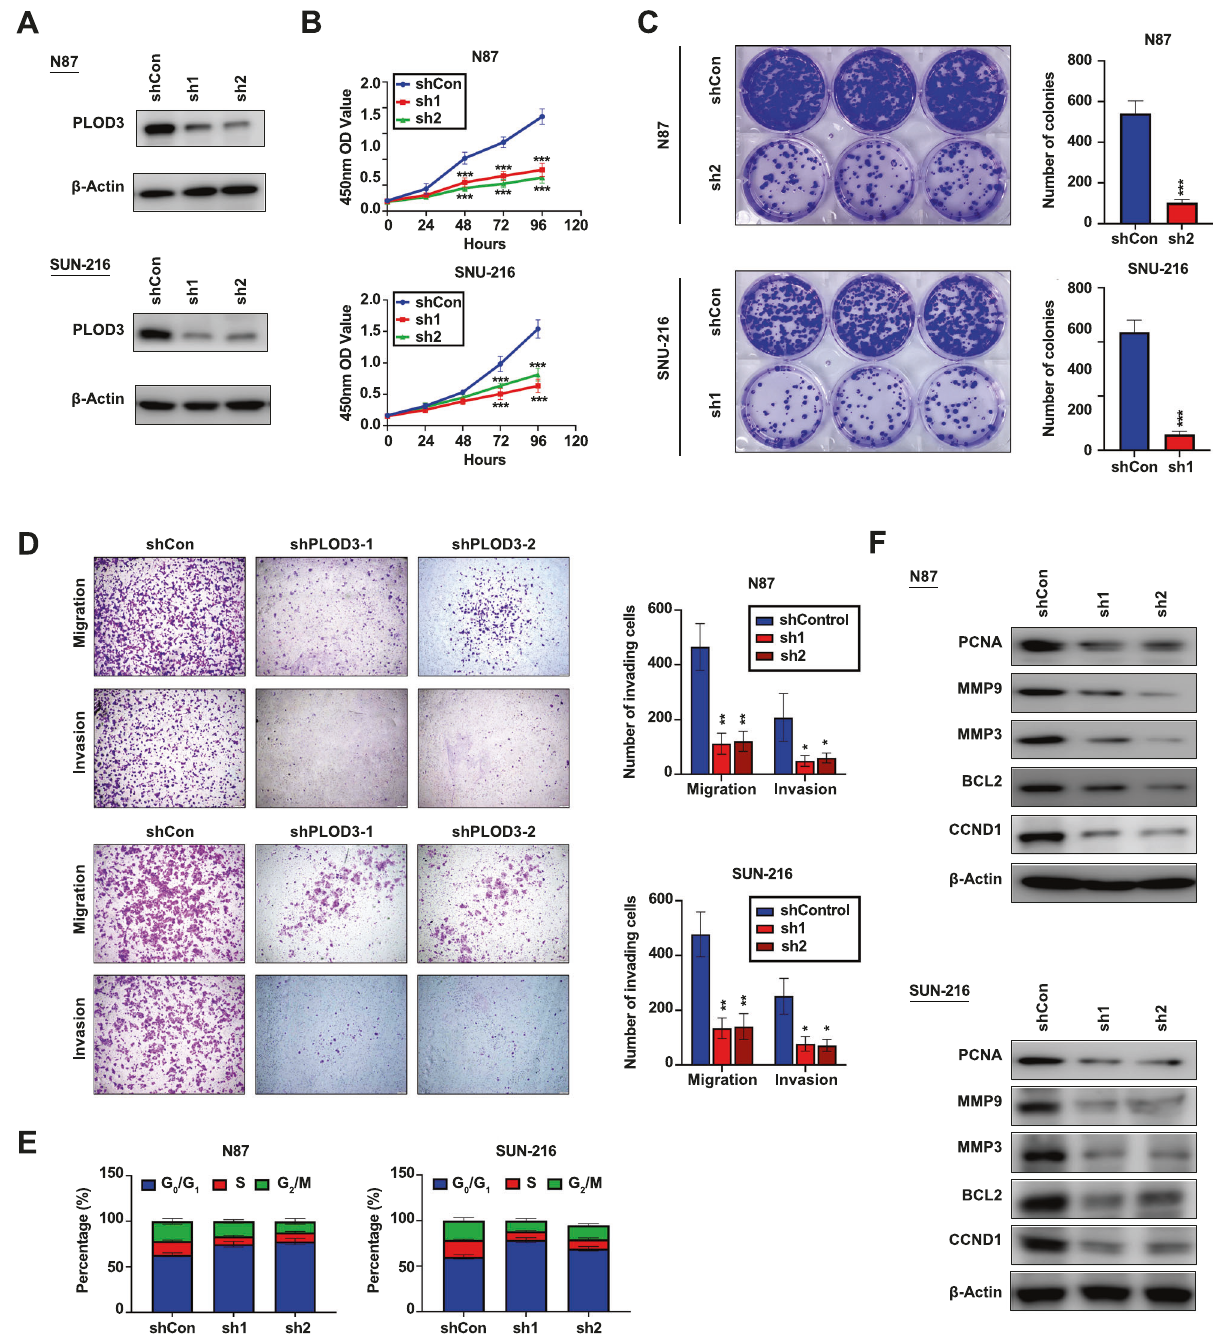
Fig. 5 The biological function of PLOD3 in vitro. A PLOD3 expression was knocked down by lentivirus in N87 and SNU-216 cell lines, and knockdown ef fi ciencies were validated by immune-blotting experiments. B , C Inhibitory effects of PLOD3 downregulation on the proliferation of PLOD3-high GC cells were validated by colony formation assays and MTT assays. D Inhibitory effects of PLOD3 downregulation on the migration and invasion capacities of PLOD3-high GC cells were validated by transwell assays. E The cell cycle variation after PLOD3 knockdown in GC cells line according to fl ow cytometry assays. F The expression levels of invasion and proliferation-related markers were assessed by western blot. survivin pathway in gastric cancer. Depletion of PLOD3 leads to increased Trastuzumab sensitivity by using in vitro and in vivo GC models. In addition, patients in PLOD3-high group also show higher possibility of developing Trastuzumab resistance in GC cancer. DISCUSSION Currently several randomized clinic trials have been focusing on In our study, we show that PLOD3 is a key mediator for HER-2 the possible mechanism of HER-2 resistance. Anti-HER-2 antibody resistance through downregulating FoxO3 therefore promoting Cell Death Discovery (2022)